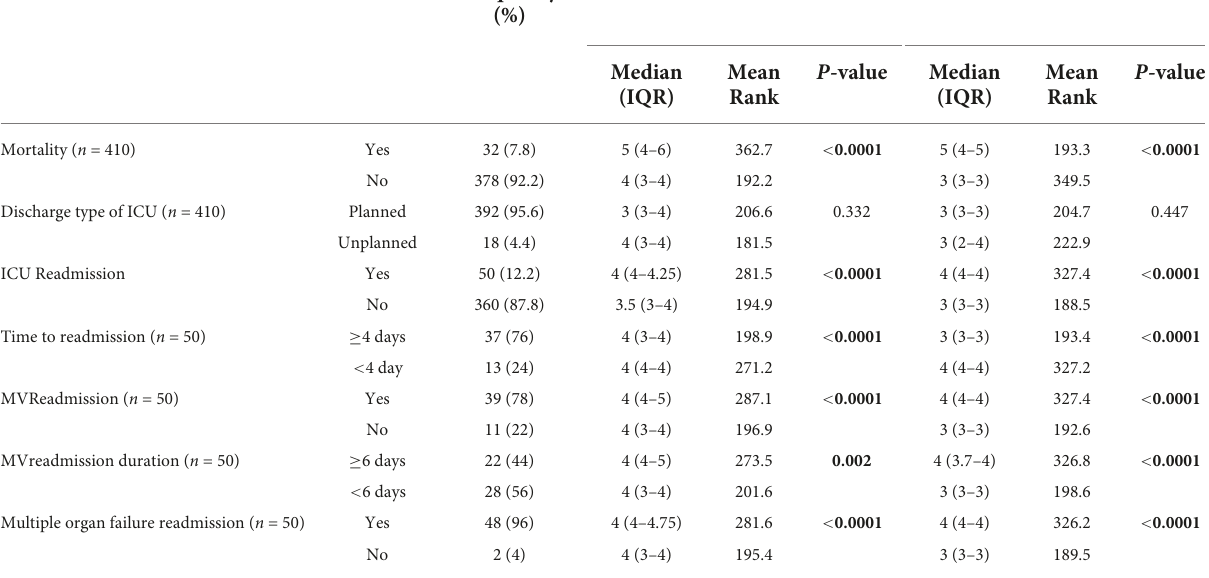
TABLE 3 Comparison of NEWS and MEWS scores according to the outcomes and subgroups of